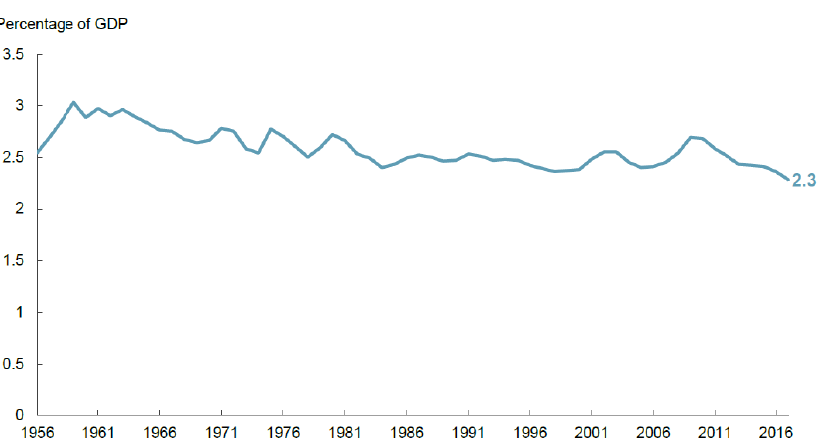
Figure 1. Public spending on transportation and water infrastructure as a share of GDP, 1956–2017. Source: Congressional Budget Office, using data from the Office of Management and Budget, the Census Bureau, and the Bureau of Economic Analysis. GDP = gross domestic product [13].